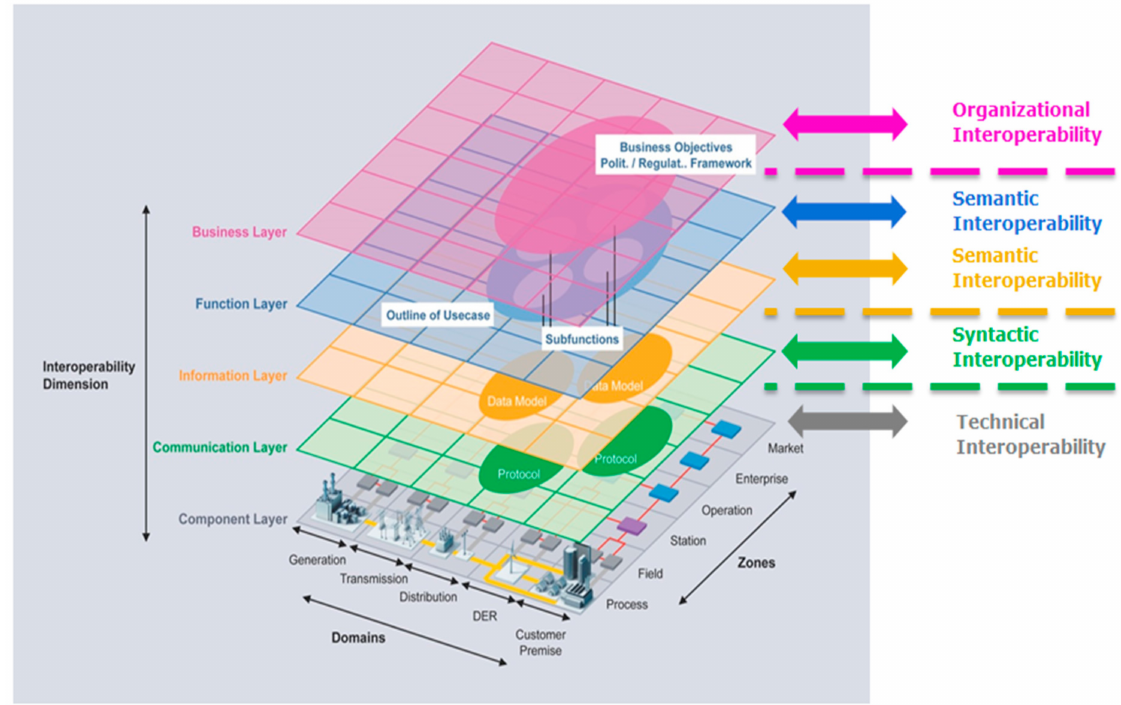
Figure 2. SGAM model and Interoperability Types